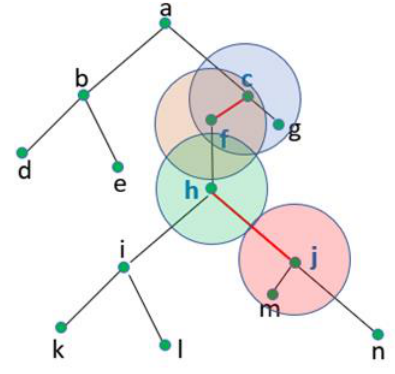
Figure 1. Violation zone formation.